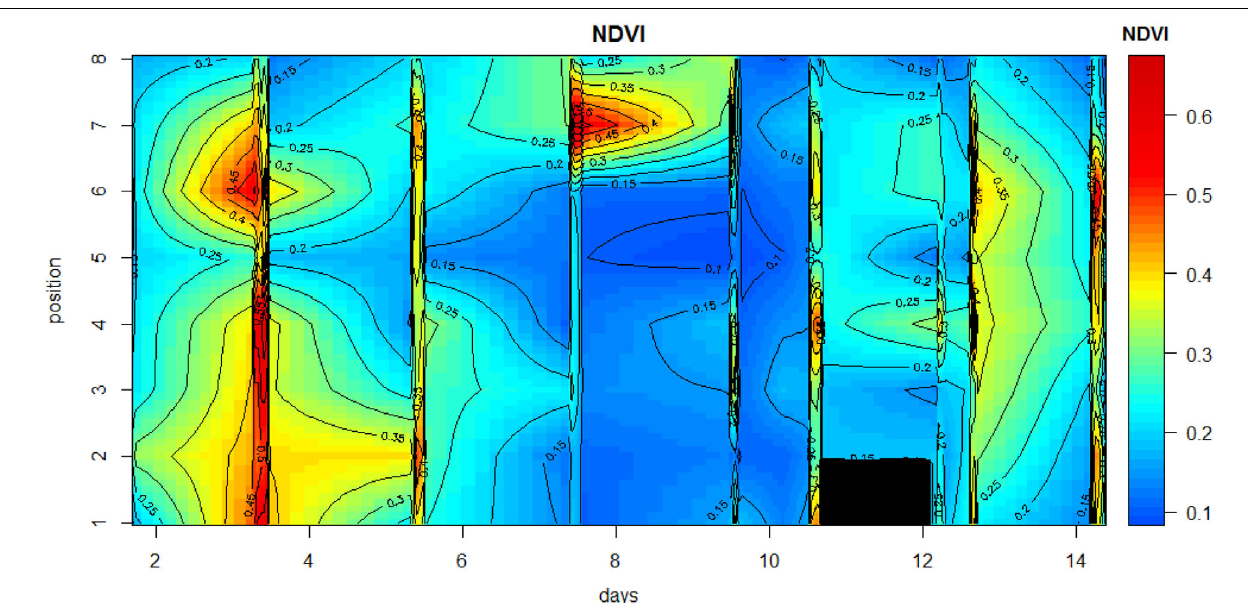
FIGURE 5 | Contour plot of the changes in NDVI along the 1-m transect during the measuring period. The days on which no measurements were carried out were omitted from the data plot in order to avoid gaps in the plot.